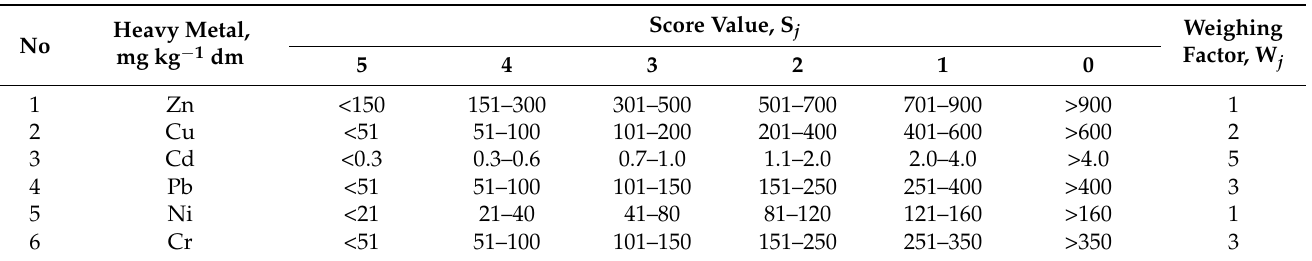
Table 2. Criteria for clean index (CI) scoring (Source: [42]). Adapted with permission from [J.K. Saha, N. Panwar, M.V. Singh], 2022,